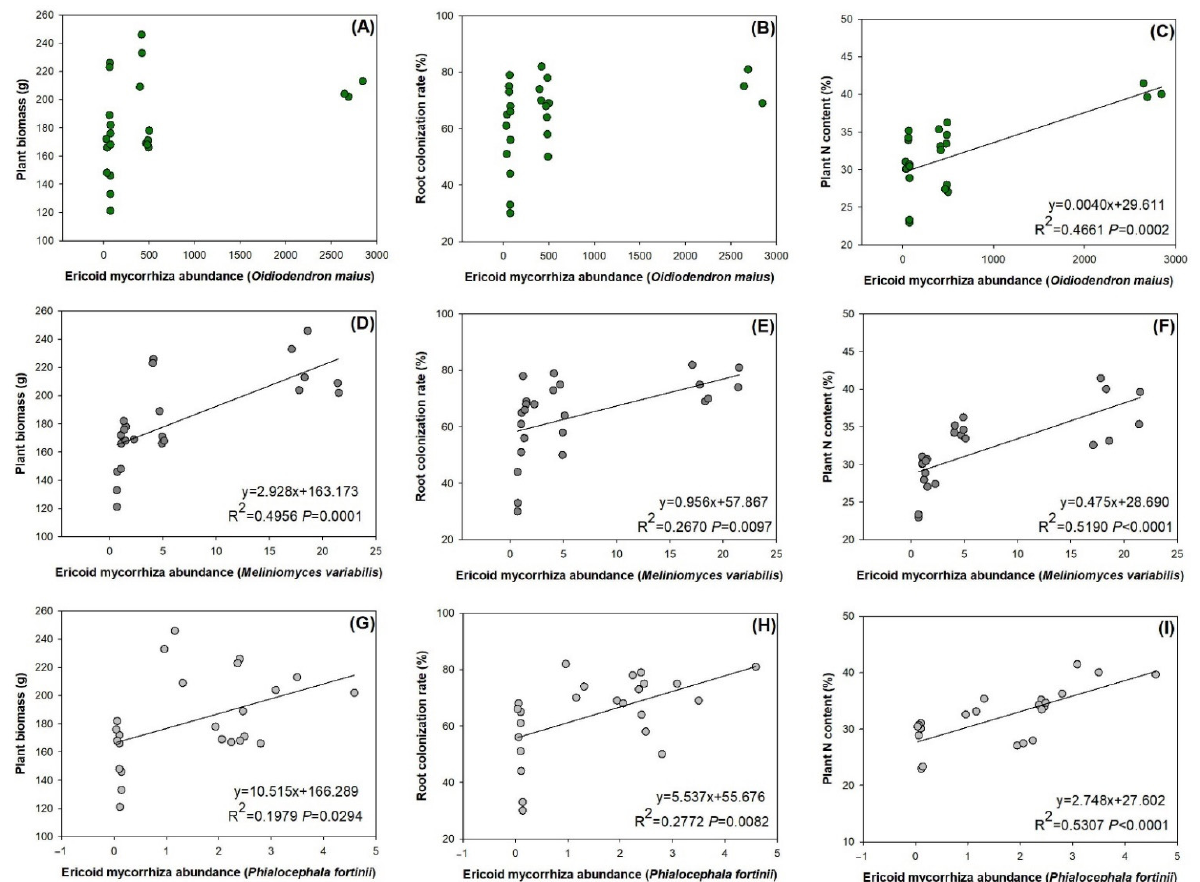
Figure 5. Relationships between ericoid mycorrhiza abundances of Oidiodendron maius ( A – C ), Melin- iomyces variabilis ( D – F ), and Phialocephala fortinii ( G – I ). Significant relationship is labelled as linear correlations with determinative coefficient (R 2 ) and p values were disclosed.